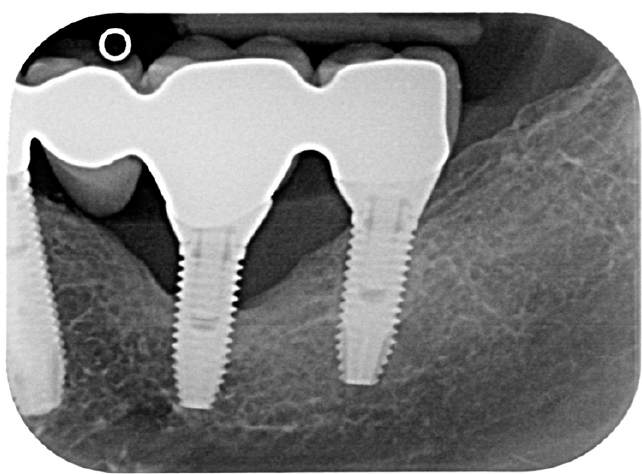
Figure 1. Periapical radiograph of one case of peri-implantitis in a non-diabetic subject.